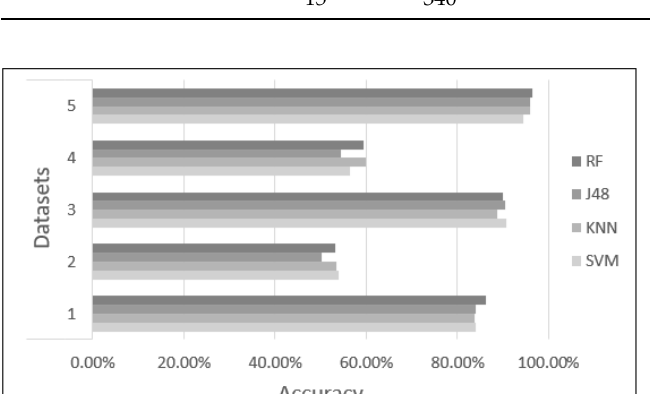
Figure 6. Difference in accuracy among the different classification methods.